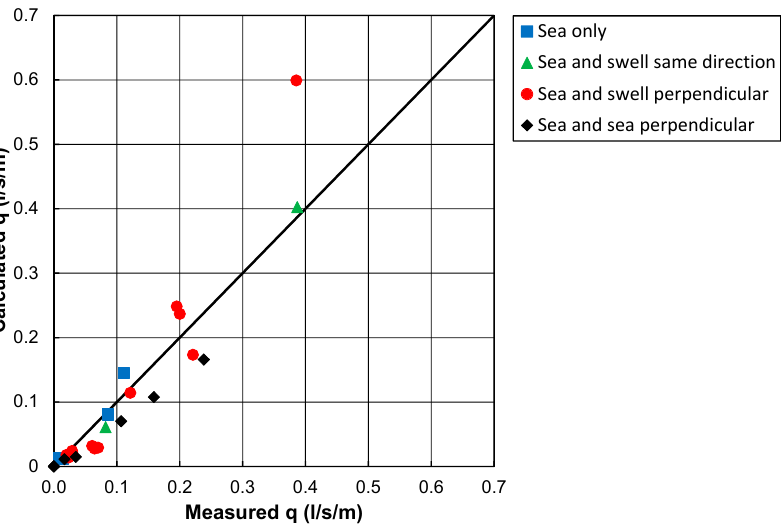
Figure 7. Measured versus calculated wave overtopping, using Equation (13).